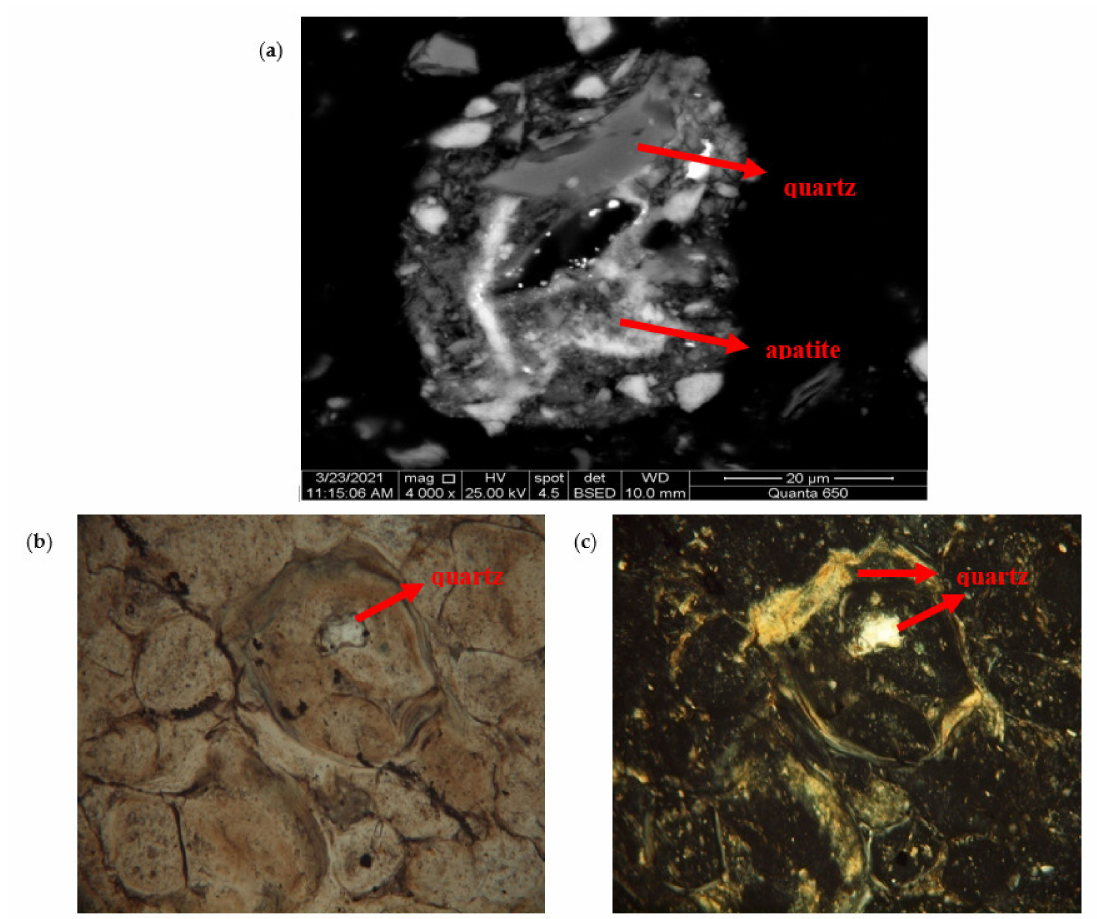
Figure 6. Cementation of microcrystalline quartz with apatite (like stromatolite): ( a ) BSED mode, ( b ) single polarization, and ( c ) orthogonal